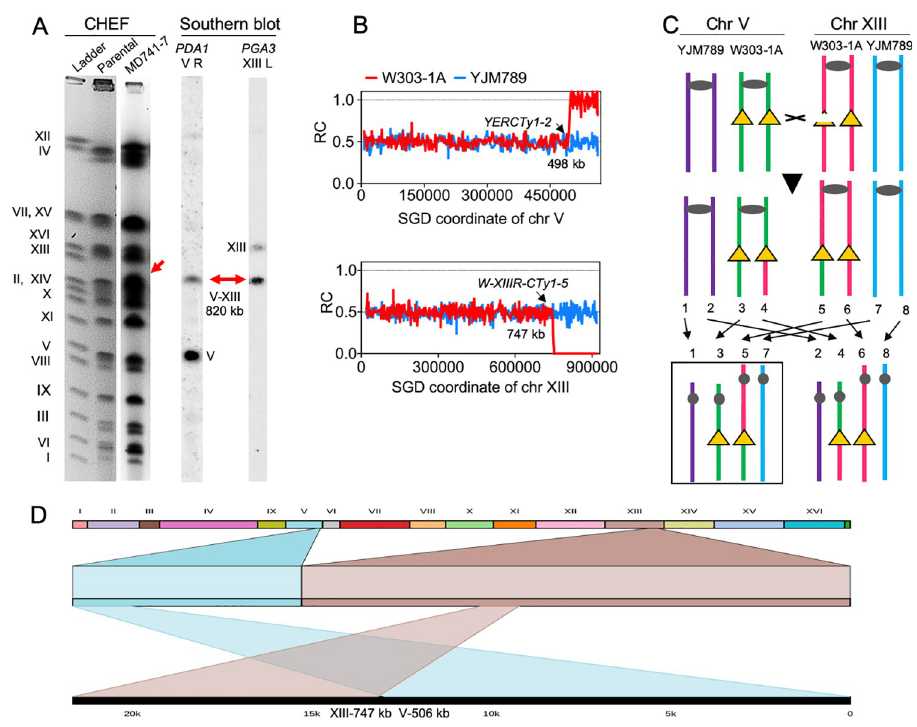
Fig 6. Analysis of the translocation in MD741-7. (A) CHEF gel showing a novel chromosome band at 820 kb. This chromosome hybridizes to probes derived from the right end of chromosome V and the left end of chromosome XIII. (B) Sequencing data showing a T-DUP on chromosome V and a T-DEL on chromosome XIII; both breakpoints are at Ty1 elements (Dataset S2.1 in S2 Data). (C) Production of the translocation by crossing-over between Ty elements (shown as yellow triangles). The translocation could also result from a BIR event (Fig 6B). (D) Nanopore sequencing of a chromosome V-XIII translocation (depiction by Ribbon software). The breakpoints of the translocation are 493,149 on V (close to a Crick-oriented Ty at 493 kb, S2 Data) and 748,223 (close to a Crick-oriented Ty at 748 kb, S2 Data) on XIII.